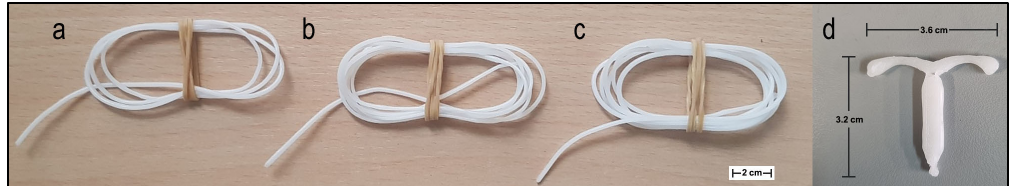
Figure 11. Images ( a ) Blank PCL Filament, ( b ) PCX:CD PCL Filament, ( c ) CBP:CD PCL Filament, and ( d ) 3D printed